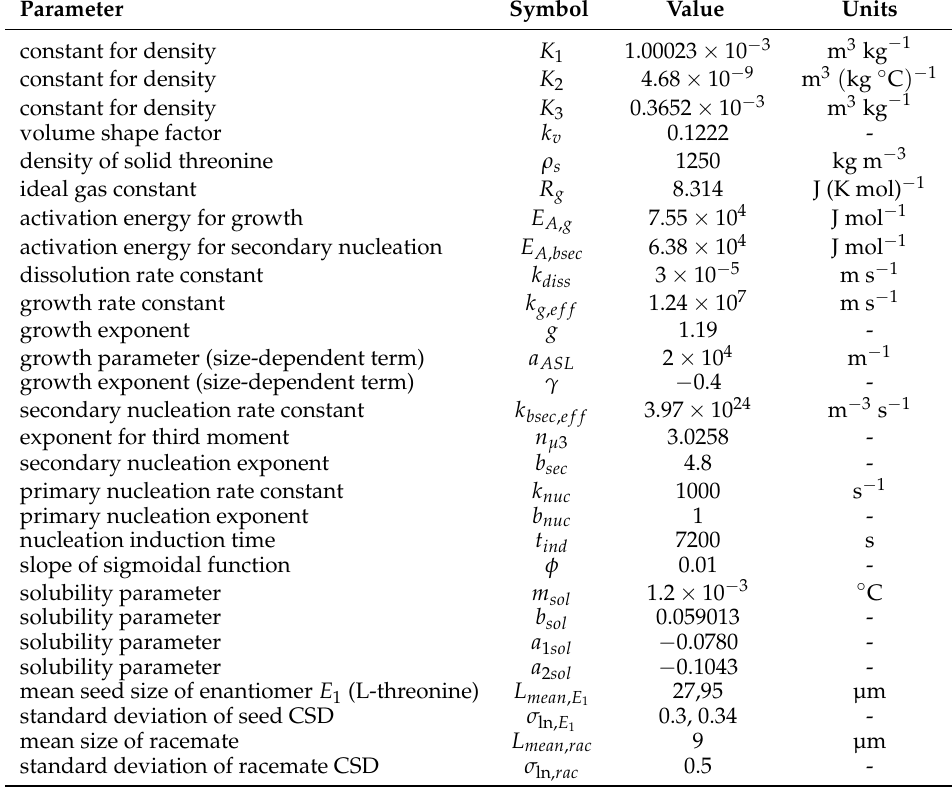
Table A1. Kinetic and simulation parameters for the ternary system DL-threonine/H 2 O [10,11]. CSD: crystal size